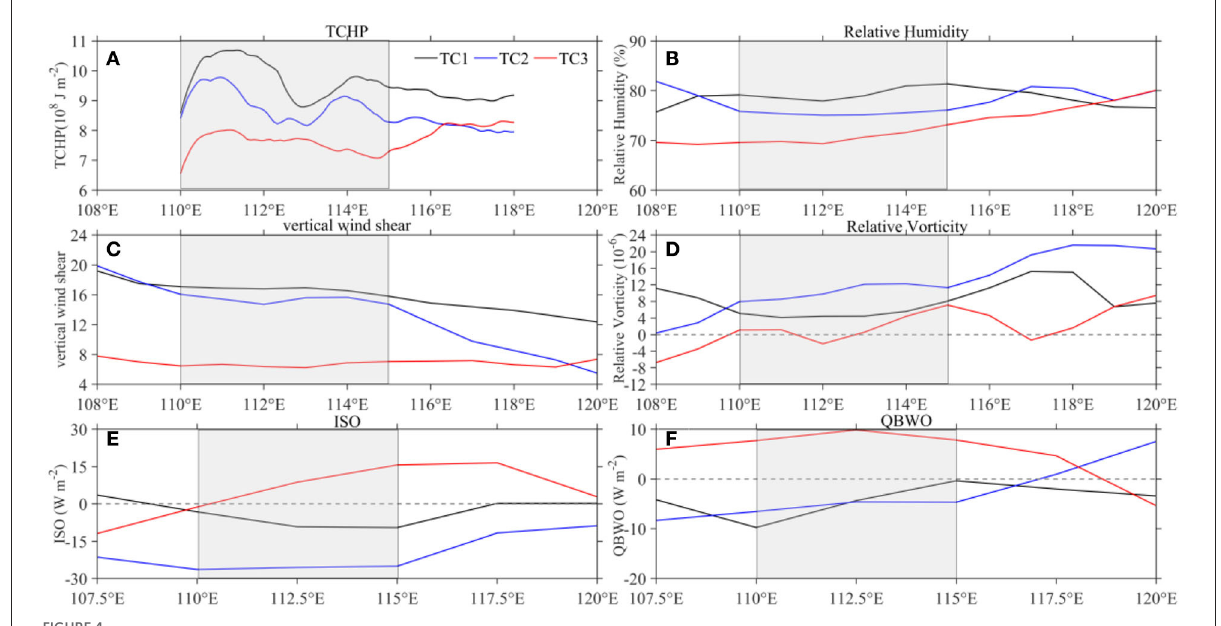
FIGURE4 The 12 ◦ N − 18 ◦ N meridional averaged TCHP on 1 day before TCs encountered with warm eddy (A) , 600 hPa relative humidity (B) , vertical wind shear (C) , 850 hPa relative vorticity (D) , convective activities related to ISO (E) , and QBWO (F) during 3 days before TCs entered the SCS. Black (blue and red) line represents the zonal variation of environmental variables or intraseasonal convective activities related to TC1/Conson, TC2/Chanthu, and TC3/Mindulle, respectively. Dotted line indicated the zero value of relative vorticity (D) and ISO (E) as well QBWO (F) . Gray shaded area indicates the eddy